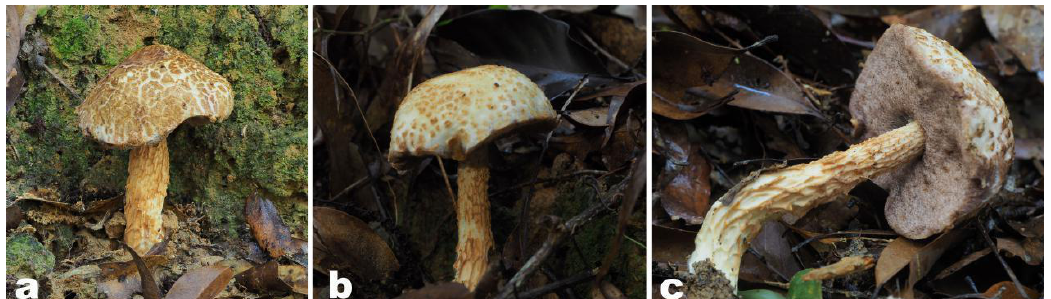
Figure 2. Basidiomata of Austroboletus brunneisquamus (( a ) from FHMU5875; ( b , c ) from FHMU5876, holotype). Photos by Y.G. Fan.